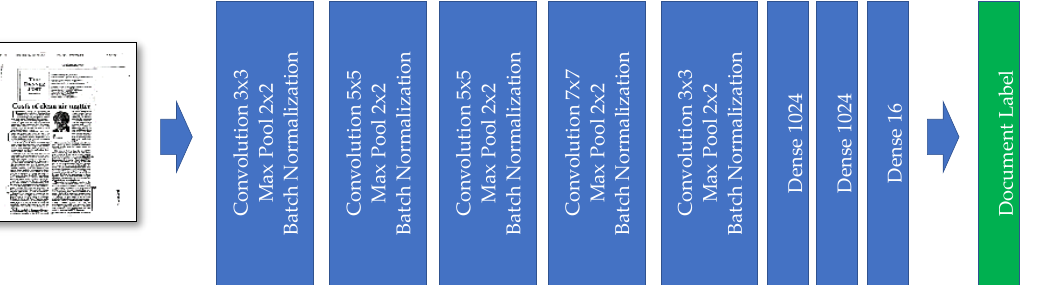
Figure 5. The “ Model I ” developed for document image classification. Figure 5. The “Model I” developed for document image